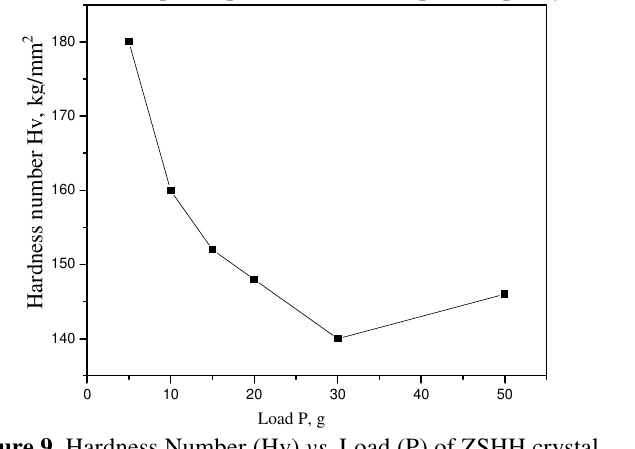
Figure 8. UV-Visible absorption spectrum of zinc sulphate hepta hydrate crystal.